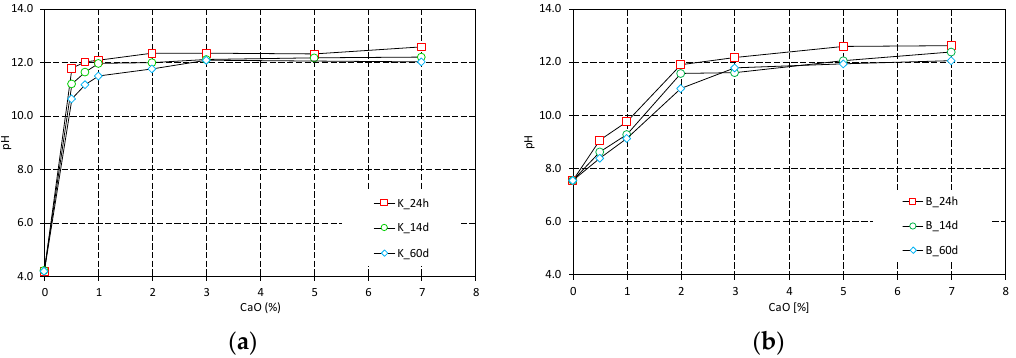
Figure 2. pH measurements of treated clays: ( a ) Spwt kaolin; ( b ) Bentonite.